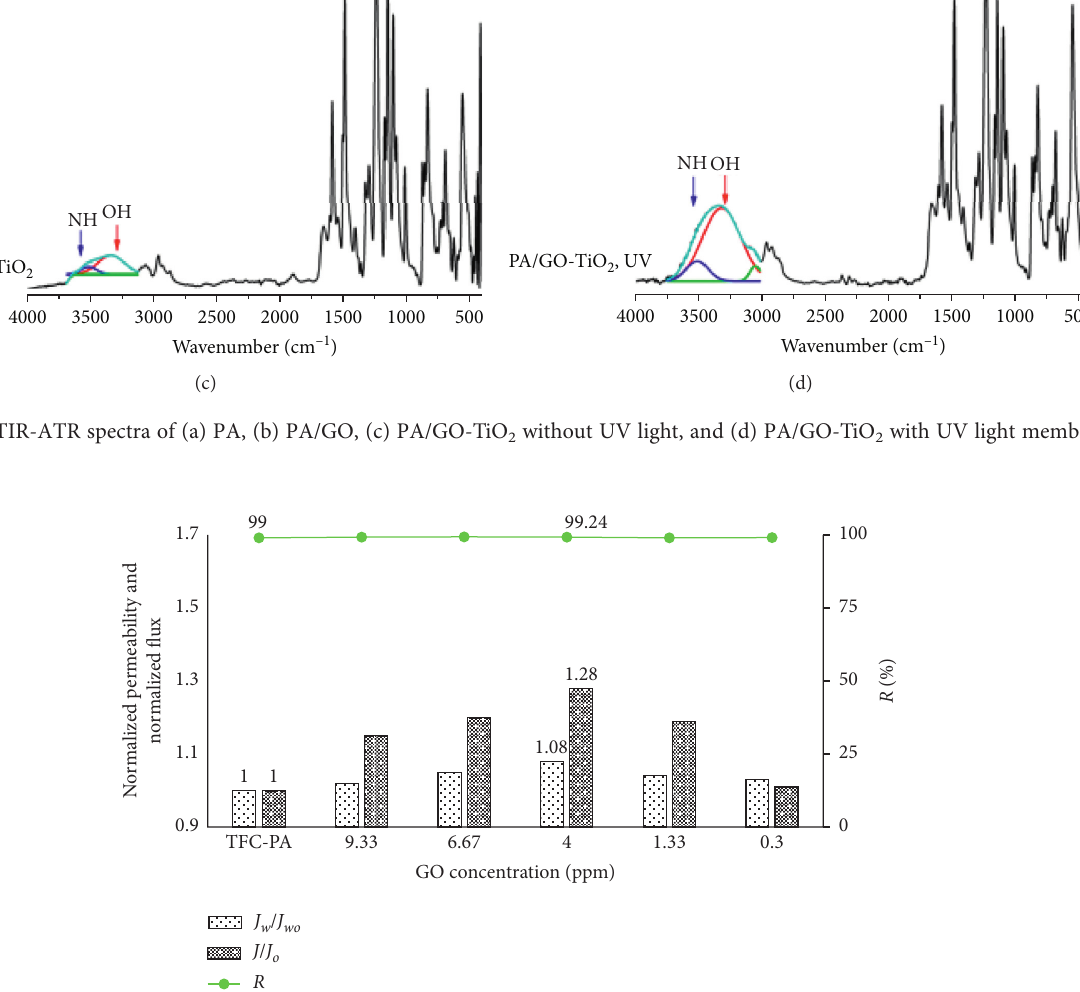
2 -coated membranes without UV